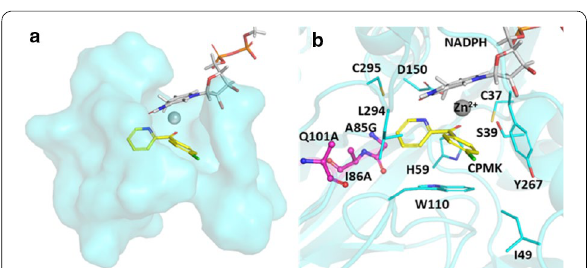
Fig. 3 Highest ranked docking pose for ketone 1 in mutant A85G/ I86A/Q101A. a Overlay of the substrate binding pocket. b ( S )-selective docking pose. The mutated residues are shown in magenta. The docking poses meet the reactivity requirements and are consistent with the formation of ( S )-